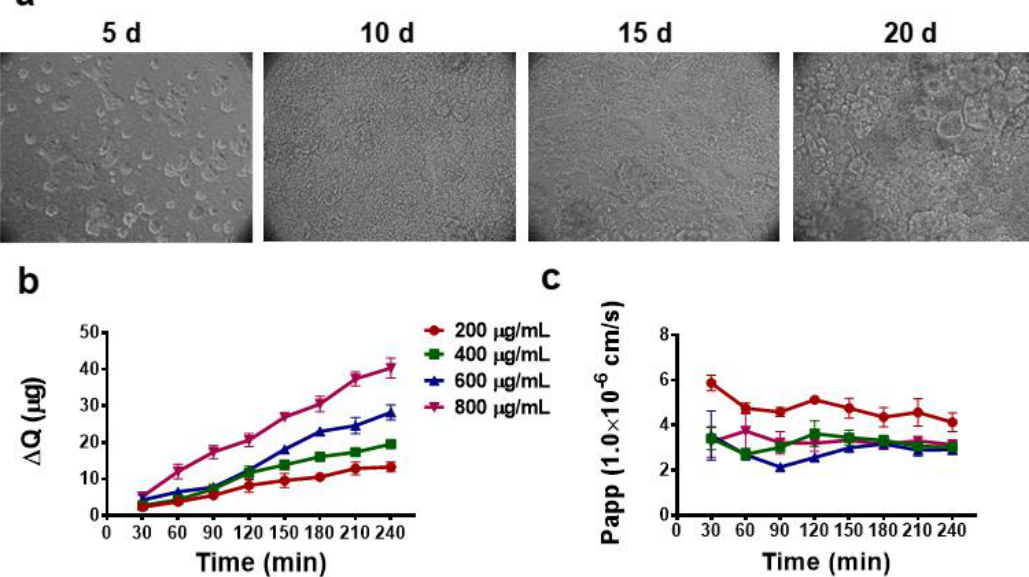
Figure 5. ( a ) The morphology of Caco-2 cells (Transwell plates) at different cultivated days (5 d, 10 d, 15 d, 21 d); ( b ) The accumulated transport amount curve of LBP-F through Caco-2 cell monolayer; ( c ) Papp values of LBP-F from AP to BL.